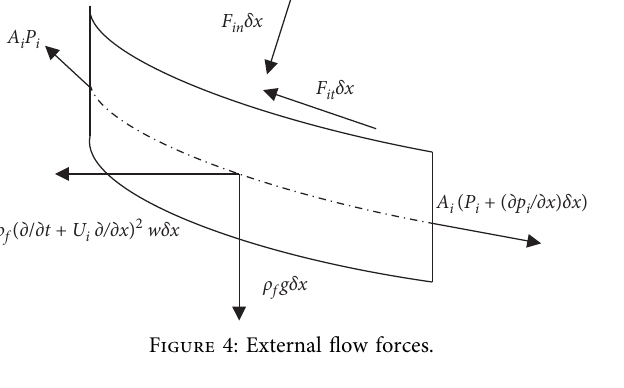
Figure 4: External flow forces.